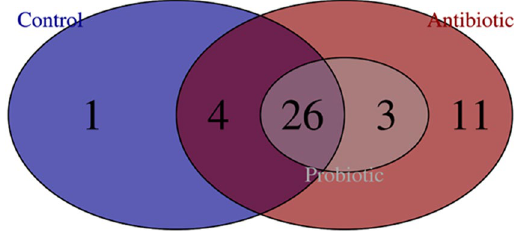
Figure 7. Venn diagram of the core shared bacterial families and unique families present in cecal microbiome of broilers from the different treatment groups (i.e. multi-strain probiotic, antibiotic combination and